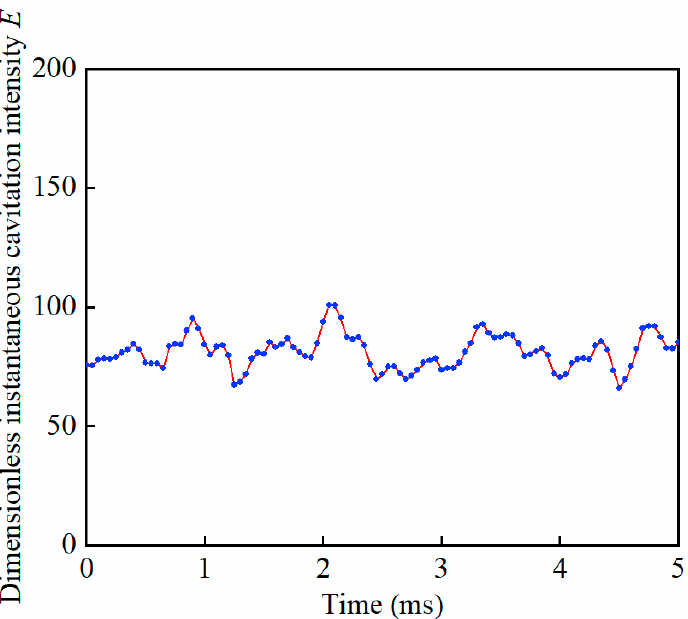
Figure 4. Variation in dimensionless instantaneous cavitation intensity over time, obtained by means of image processing.